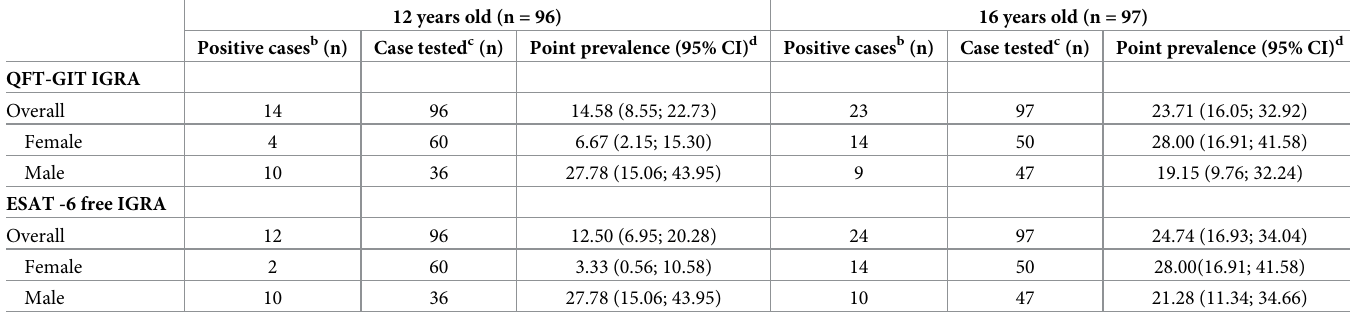
Table 2. Latent tuberculosis infection prevalence among 193 adolescents measured by QFT-GIT IGRA and ESAT-6 Free IGRA a .